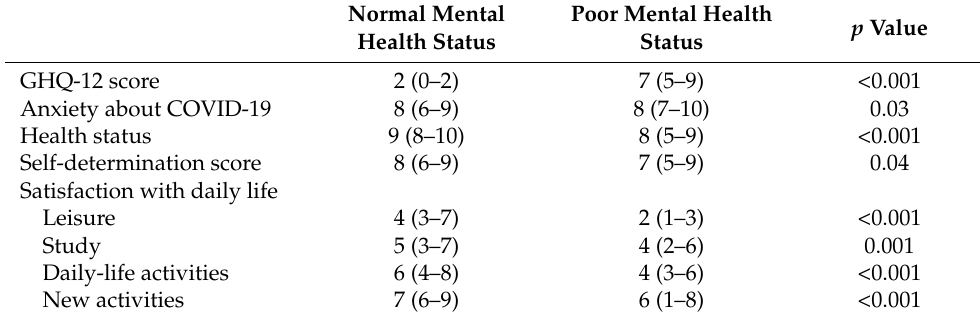
Table 4. Survey responses by mental health